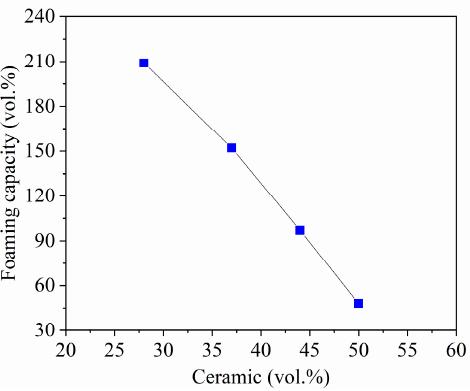
Figure 12. Foaming capacity of the MgAl 2 O 4 slurries at different ceramic loads. The micrographs of the foams obtained with 7, 11, and 21 vol.% MgAl 2 O 4 at 2360 rpm are shown in Figure 13. For all the foams, the interconnected cell microstructure is main- tained, and an increase in ceramic load induces a reduction in the size of the